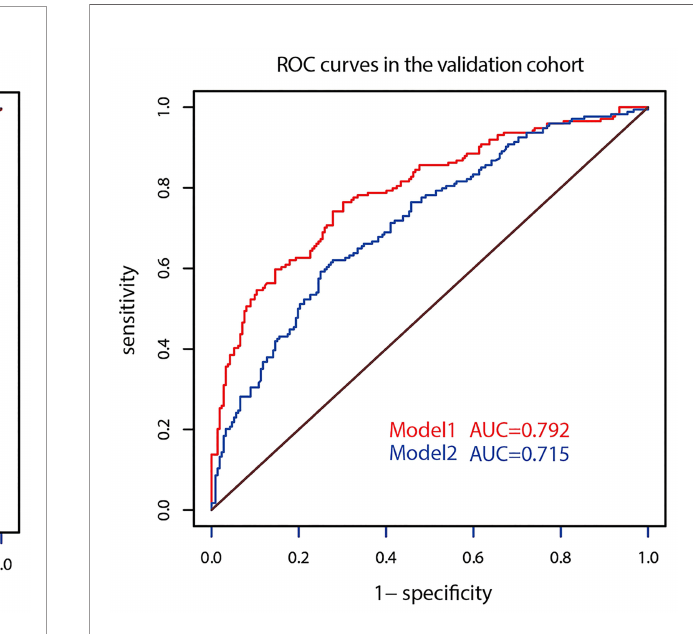
FIGURE 2 | ROC curves of the two models in the training dataset. FIGURE 3 | ROC curves of the two models in the validation